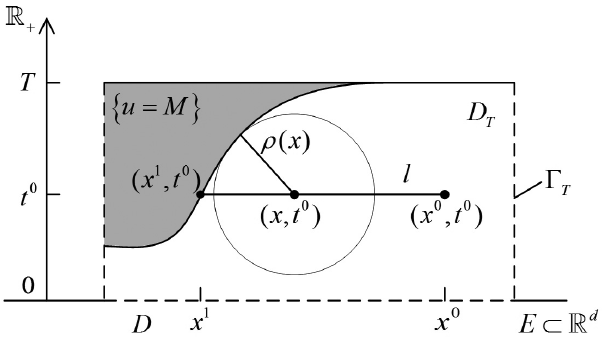
Fig. A.1. Sketch for Lemma